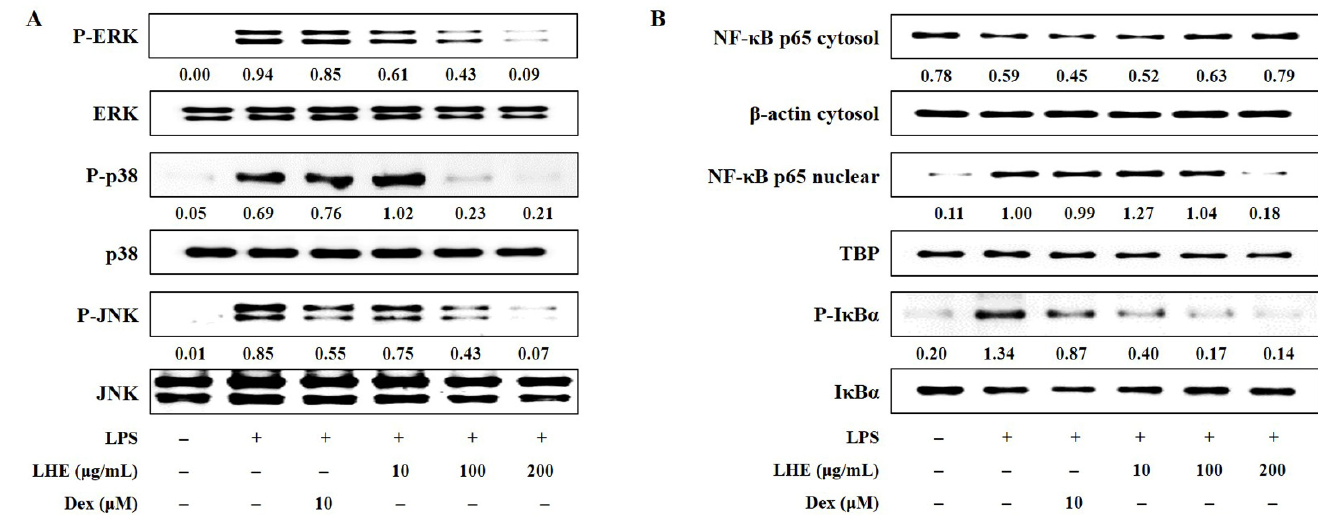
Figure 3. Effects of LHE on ( A ) the phosphorylation of MAPK and ( B ) the activation of NF- κ B in LPS-stimulated RAW 264.7 macrophages. Cells were stimulated with LPS for ( A ) 30 min or ( B ) 1 h. The quantified number showed the expression levels of protein relative to those of total-type protein, β -actin, or TBP.